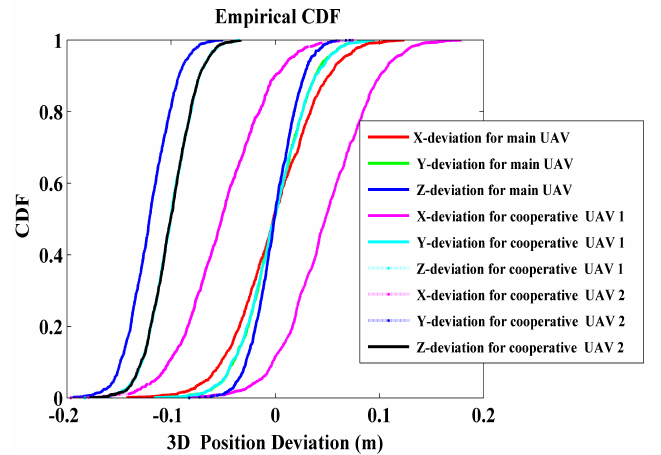
Figure 5. Empirical CDFs x , y , z values relative to the UAV target position. The impact of both gyre decoding and the T-transformation scheme on the received signal-to- noise ratio (SNR), received SINR, and achievable ergodic rate with the variation in UAV